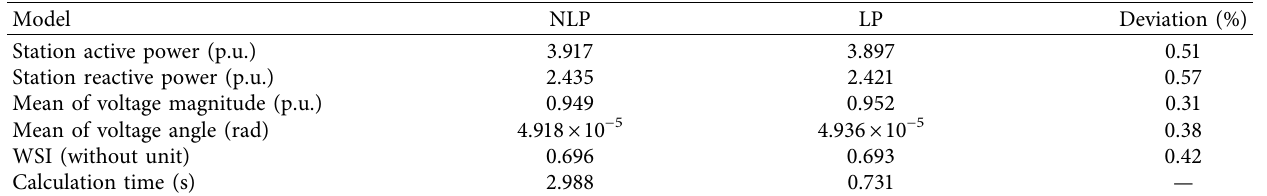
Table 3: Comparison of AC power flow analysis in the NLP and LP